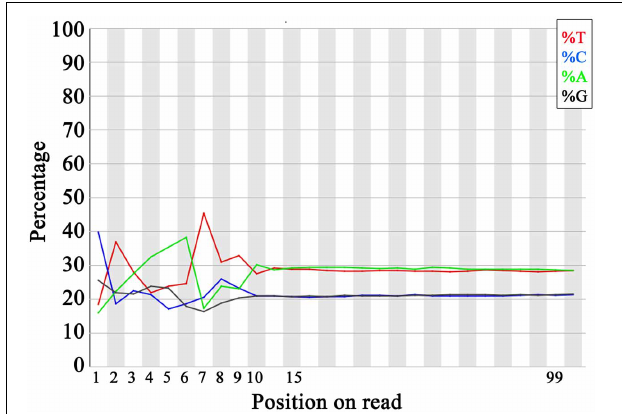
FIGURE 7 | Bias in nucleotide frequency in 5 (cid:2) end of reads. Nucleotide frequencies per position. Example of the first 200,000 reads from the first paired-end sequencing of WT_1, as calculated by the FastQC algorithm (Andrews, 2010). This bias was observed in all the sequenced samples from both paired-end sequencing rounds (data not